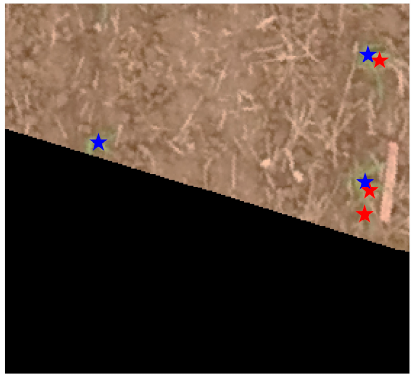
Figure 17. The image patch with high AHD and zero counting errors. Blue stars are ground truth points, and the red ones are predicted based on the model.